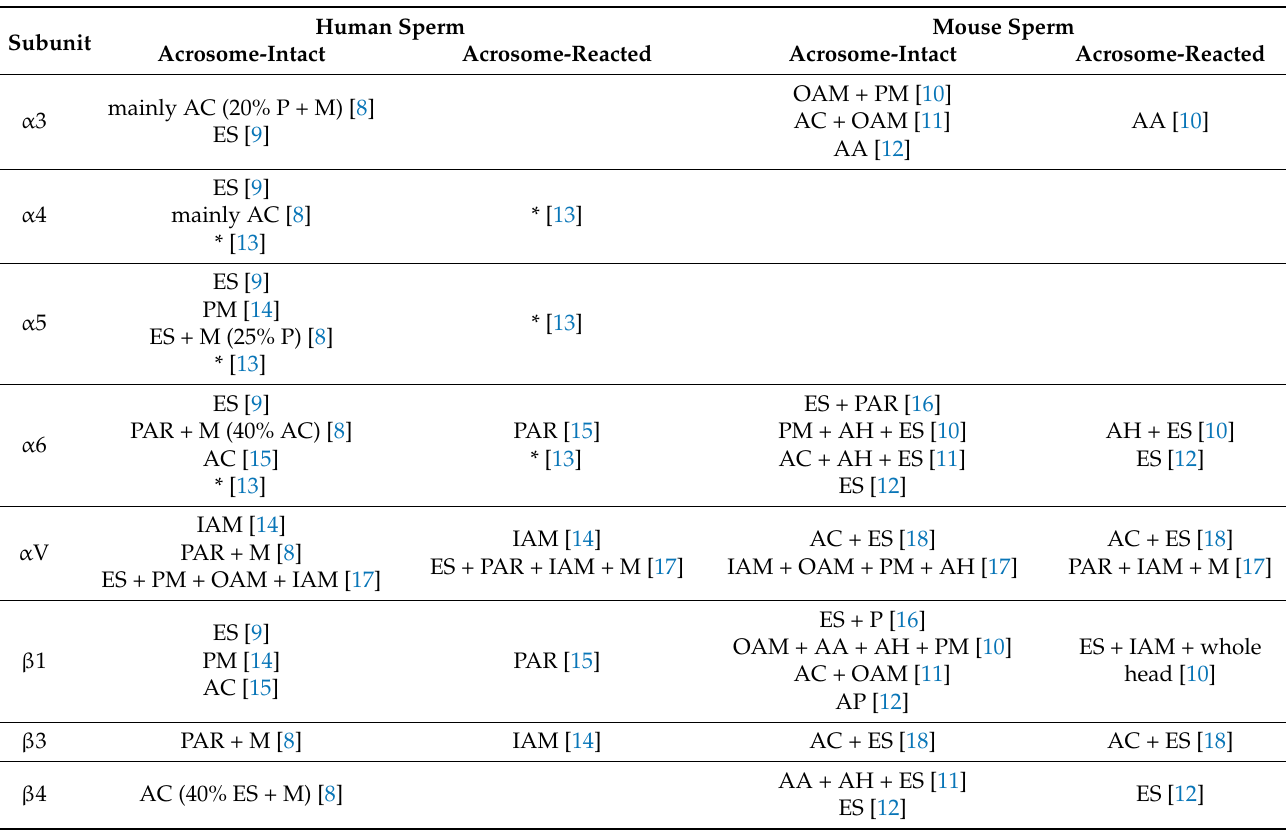
Table 1. Localization of integrin subunits on acrosome-intact and acrosome-reacted sperm in human and mouse. Abbrevia- tions are as follows: (PM) plasma membrane; (OAM) outer acrosomal membrane, (IAM) inner acrosomal membrane, (AC) acrosomal cap, (AA) apical acrosome, (AH) apical hook, (PAR) post-acrosomal region, (ES) equatorial segment, (M) middle piece, and (*) protein localization not